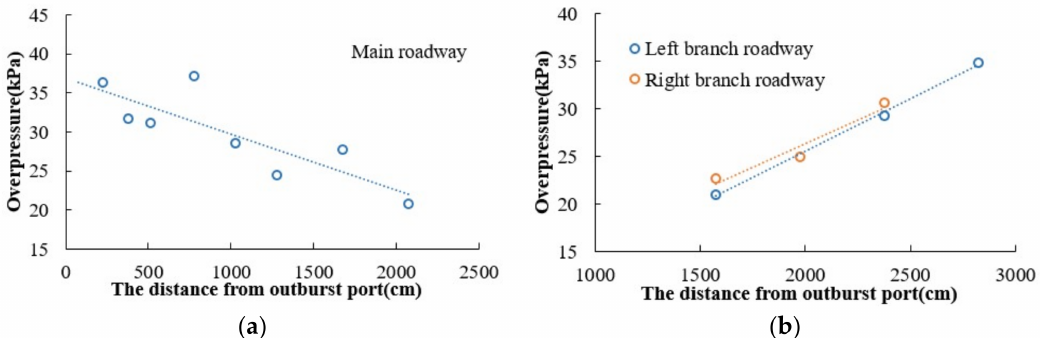
Figure 5. The distribution of shock wave overpressures along the roadway. ( a ) Main roadway; ( b ) Branch roadway.